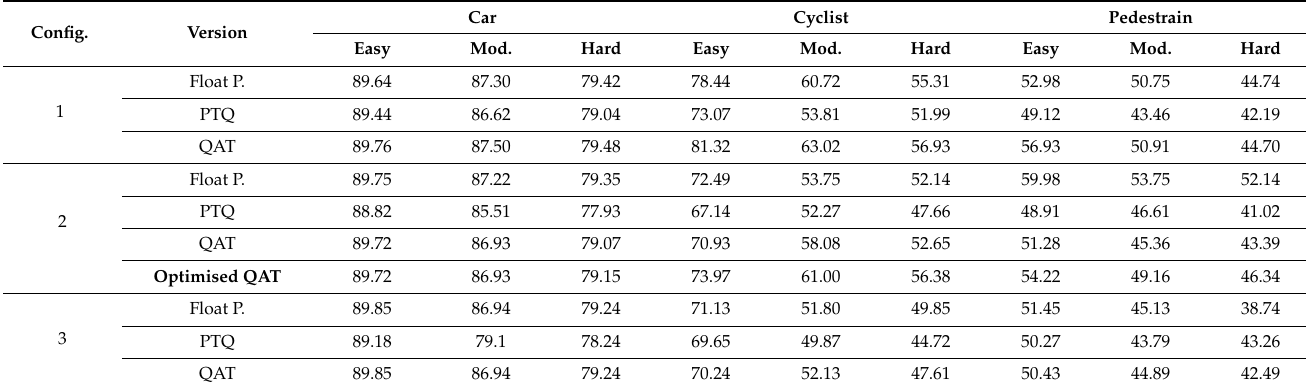
Table 13. Results of the floating-point and quantised models on KITTI BEV detection for classes Car (IoU 0.70), Cyclist (IoU 0.50), and Pedestrian (IoU 0.50)